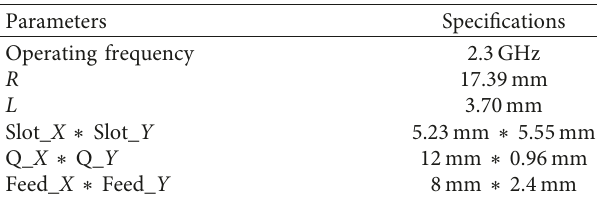
Table 1: Antenna design specifications.